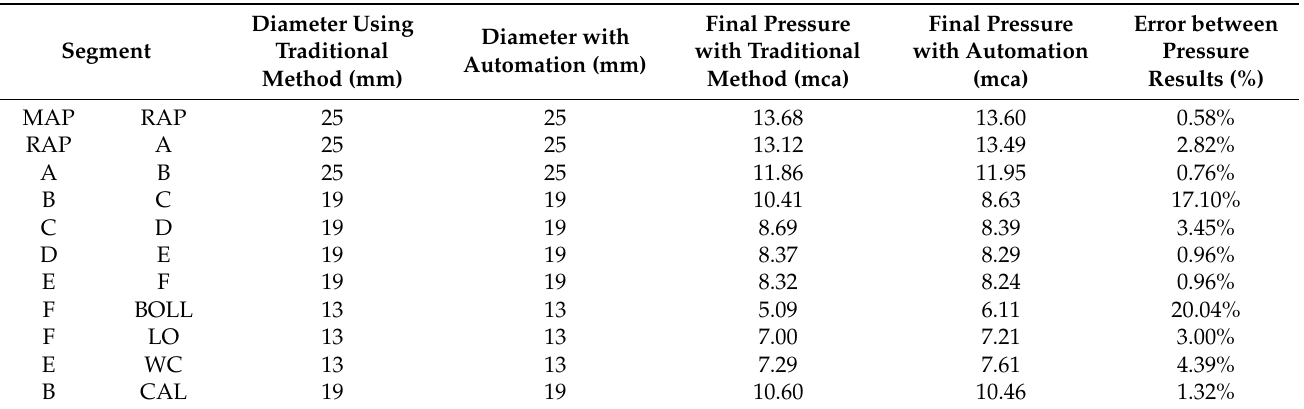
Table 24. Comparison of diameter and final pressure in a cold water system for type 2 retail store.